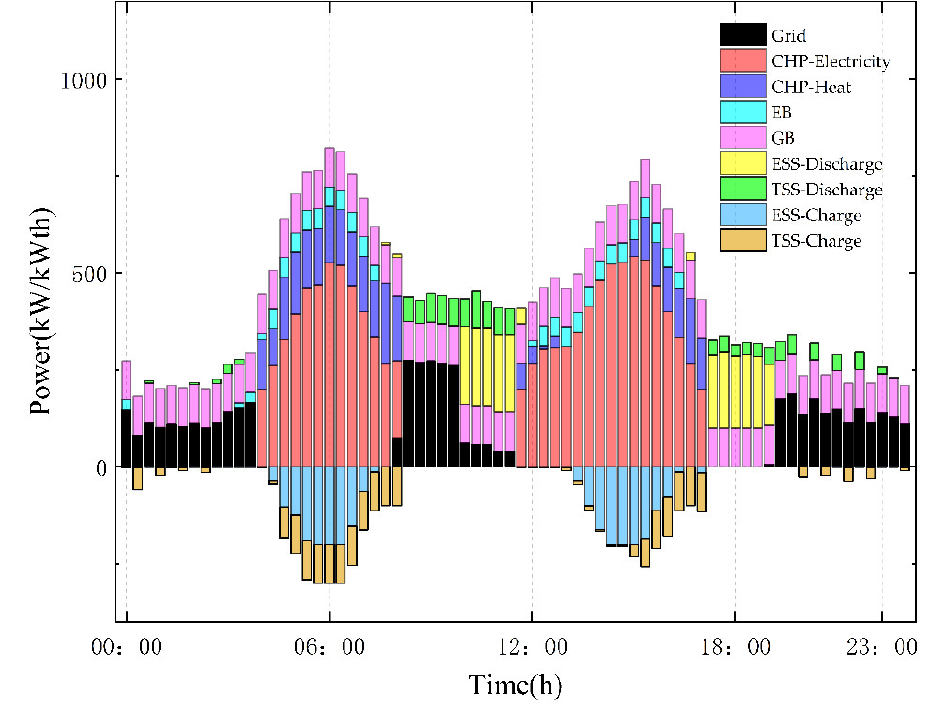
Figure 6. The operation plan of model 3 on the typical day of SSday-1 (β = 0.95).